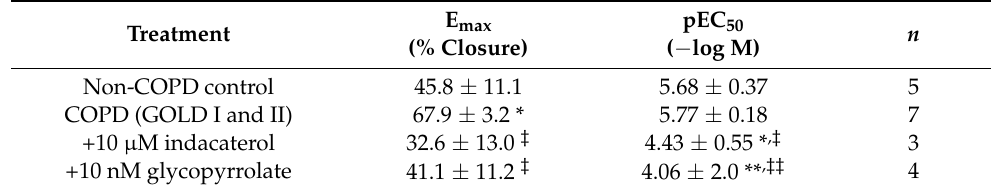
Table 3. Effects of indacaterol and glycopyrrolate on methacholine-induced airway constriction of human intrapulmonary airways obtained from non-COPD control subjects and COPD patients (GOLD I and II).